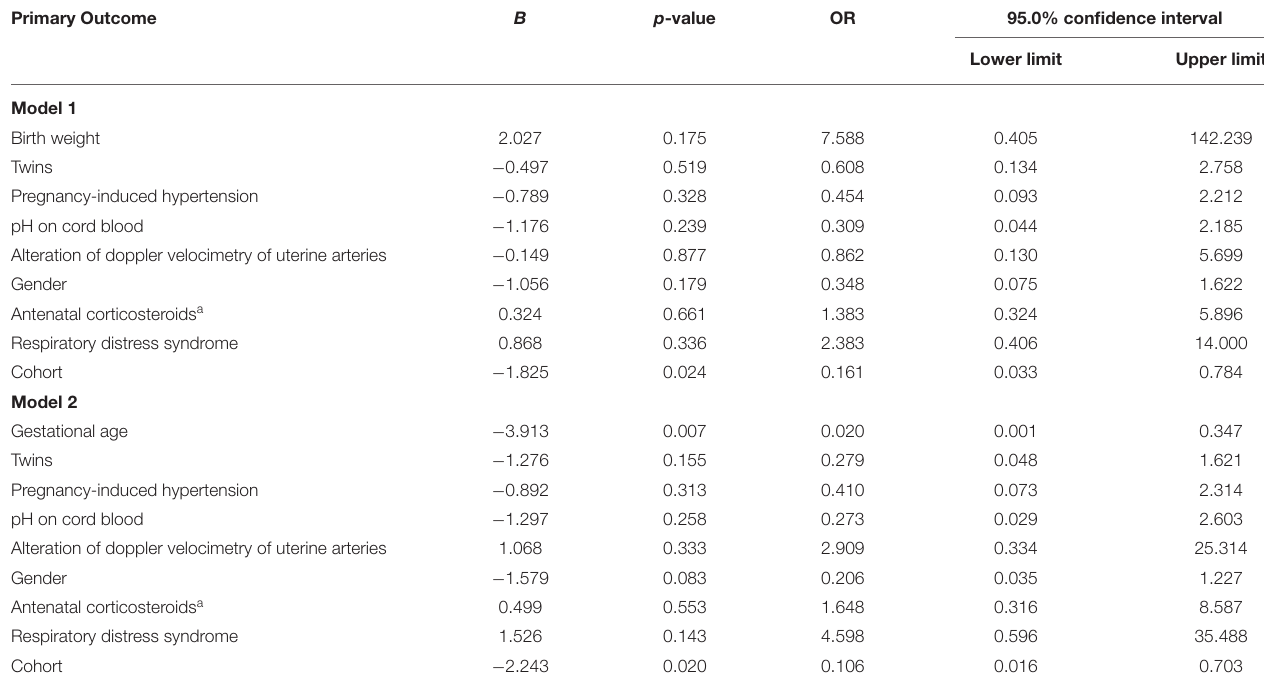
TABLE 6 | Binary logistic regression analysis to evaluate the influence of covariates on primary